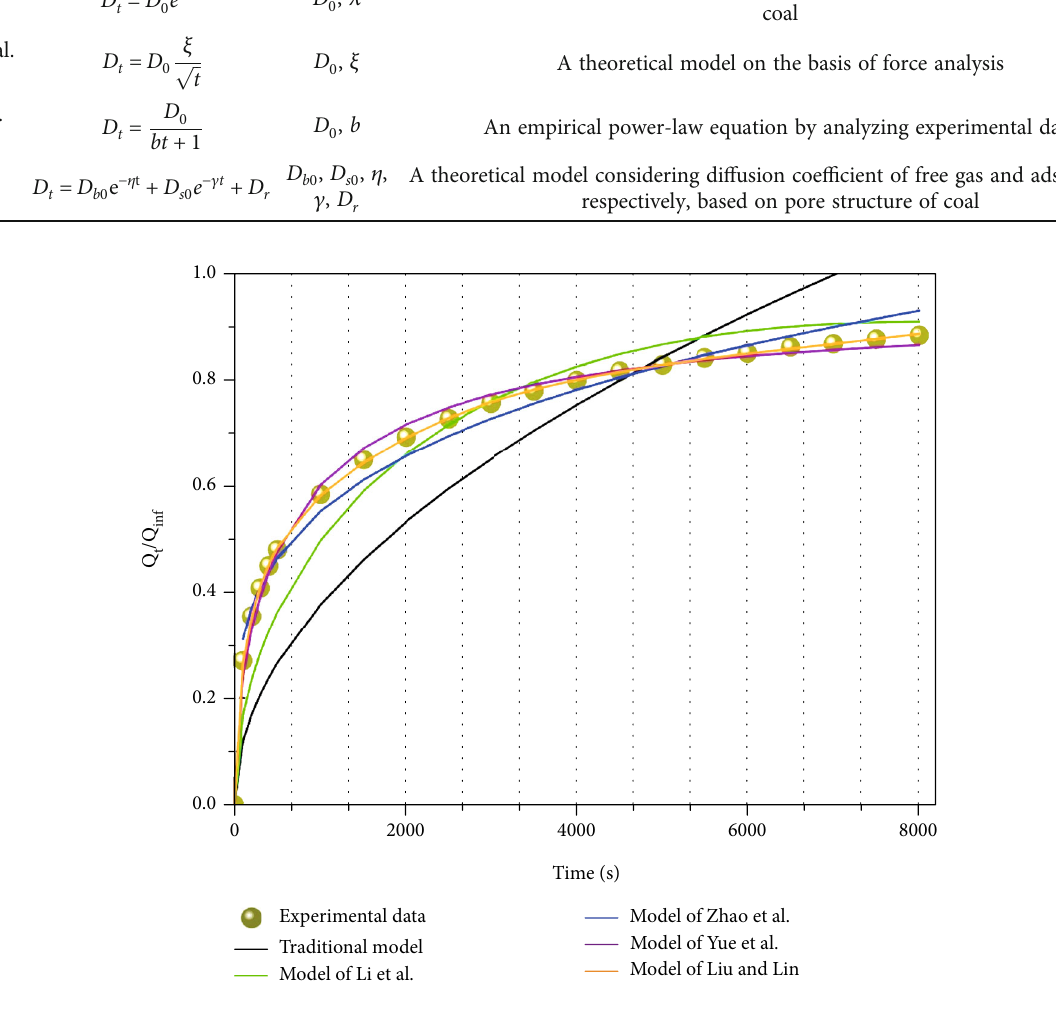
is cumulative gas di ff usion t